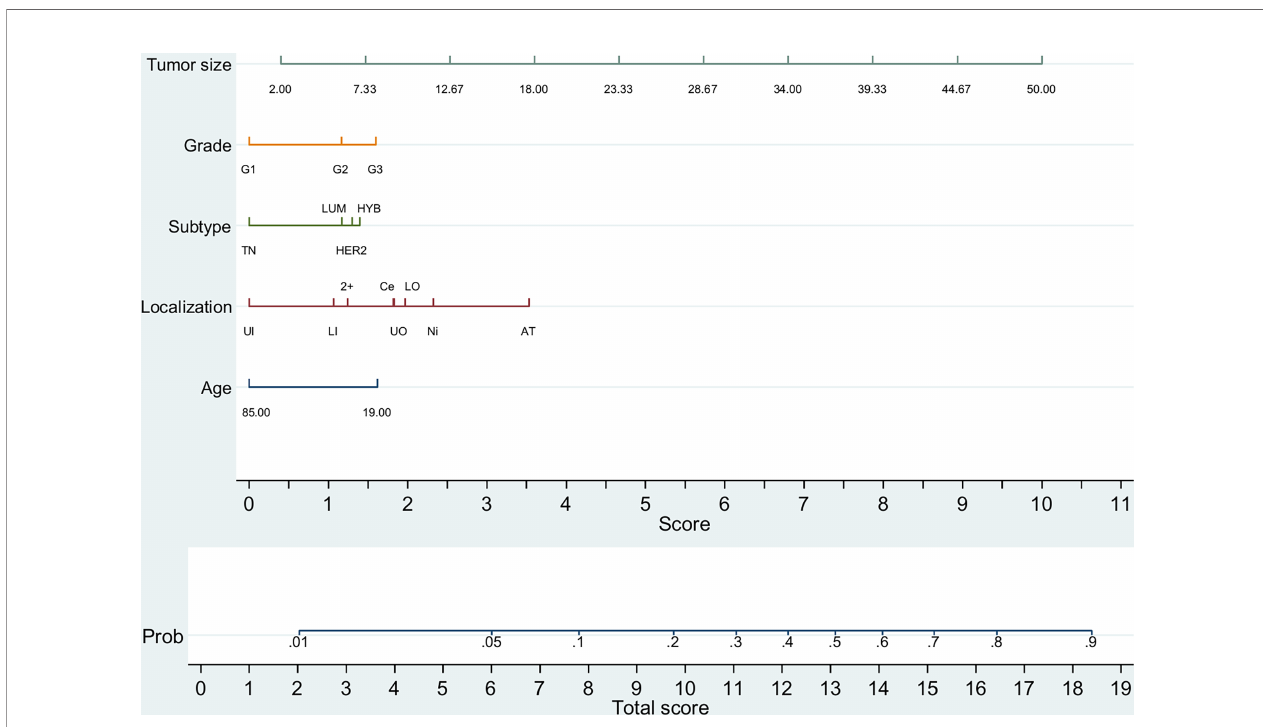
FIGURE 2 | Predictive nomogram of two or more metastatic lymph nodes in initial BCS patients ( n = 44,151). TN, triple-negative (HR − /HER2 − ); LUM, luminal (HR + / HER2 − ); HYB, luminal hybrid (HR + /HER2 + ); HER2, HER2 enriched ((HR − /HER2 +) ); UI, upper inner quadrant; LI, lower inner quadrant; 2+, overlapping quadrants; UO, upper outer quadrant; LO, lower outer quadrant; Ce, central quadrant; Ni, nipple; AT, axillary tail. Tumor size is depicted in